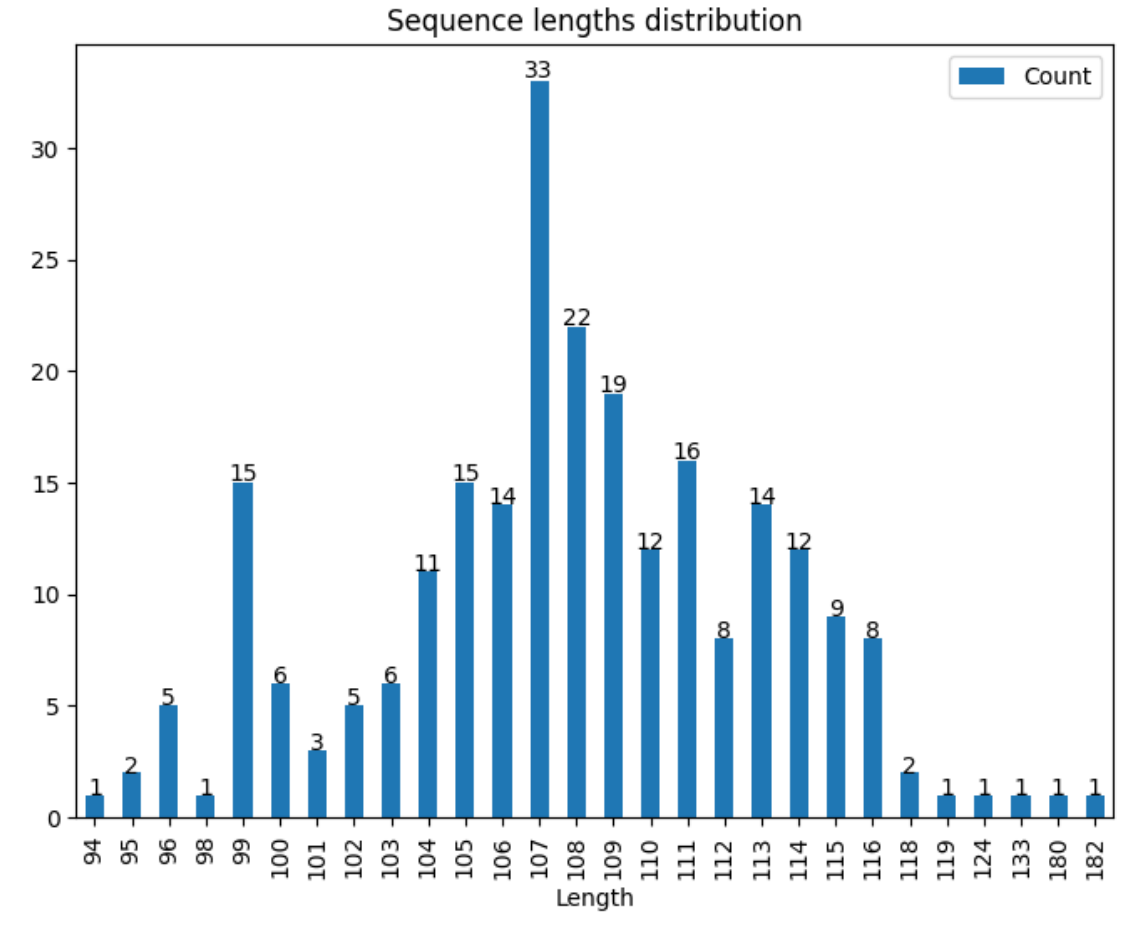
Figure 2. Sequence length distribution results from MetaLogo [45]. The sequences were grouped with a sequence identity cut-off of 90% using CD-HIT Suite [46], yielding 248 representative proteins. Check Supplementary Table S1 to view the accession numbers of the sequences.